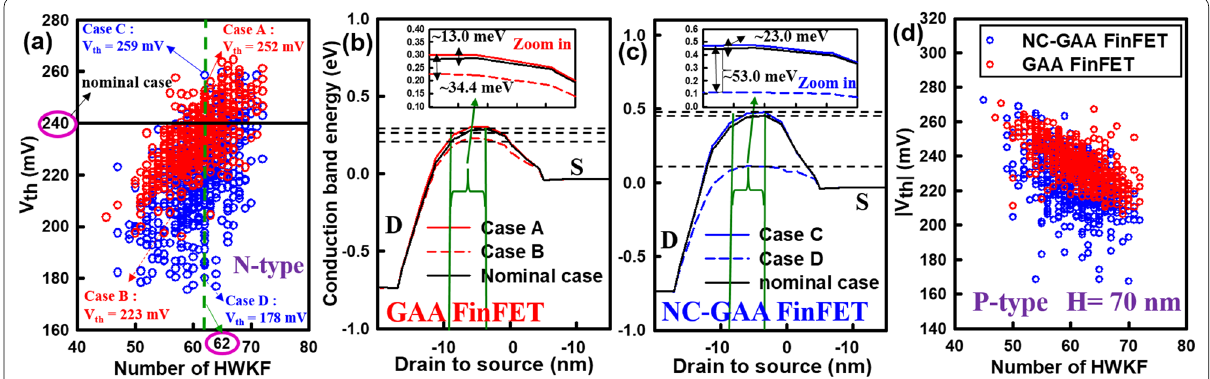
Fig. 9 a The comparison of V th distribution profile of random 500 fluctuated devices. The 1D conduction band energy profiles which are corresponding to six cases for b GAA and c NC‑GAA FinFETs. d The relevant V th distribution comparison profile of P‑type